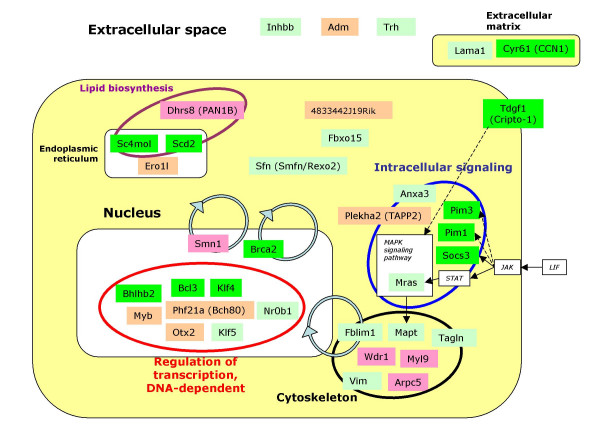
Function and sub-cellular localization of the 36 selected proteins. The colours of the labels indicate the behavior of the corresponding probe sets (dark-green: down-regulated at 6 h; light green: down-regulated at 12 h; tan: up-regulated at 12 h; pink: up-regulated at 6 h). Pathways and other related proteins are indicated with white labels. Circular arrows indicate transport between cytoplasm and nucleus. Solid and broken arrows indicate direct activation and activation through intermediate proteins, respectively. Information about the JAK-STAT and MAPK pathways was taken from the references listed in this manuscript or from the KEGG database [73].